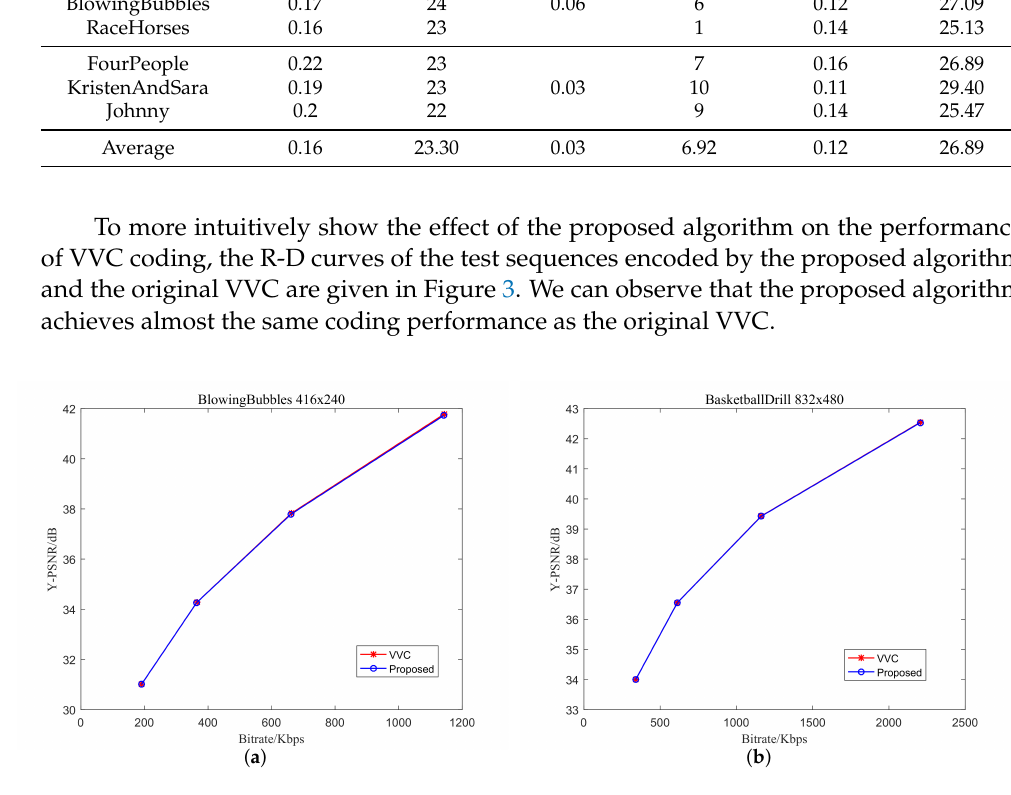
Figure 3. The R-D curves of sequences “BlowingBubbles” (Class D) and “BasketballDrill” (Class C) under AI configuration. ( a ) BlowingBubbles; ( b )